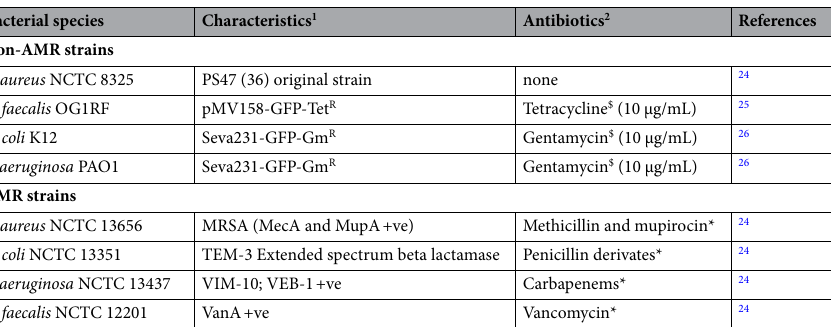
Table 1. Bacterial strains used in this study. 1 Genetic feature of the selected strains. 2 Antibiotics to which AMR strains are resistant to* and antibiotics used in the cultures of the non-AMR strains $ to maintain the expression of the GFP plasmids over time (concentrations indicated in